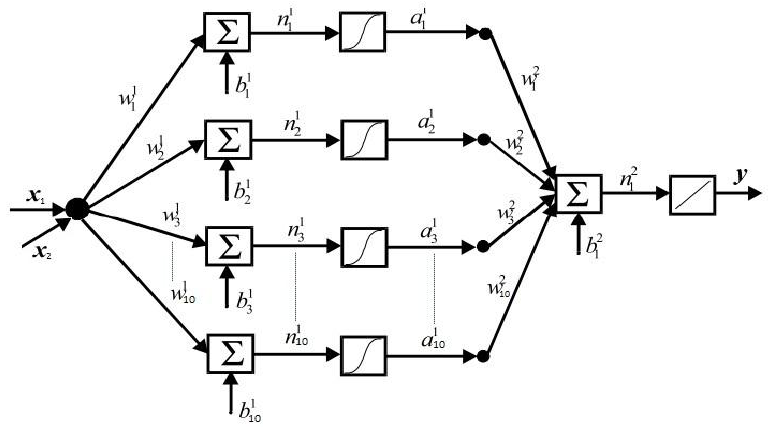
Figure 2. Architecture of the artificial neural networks used.